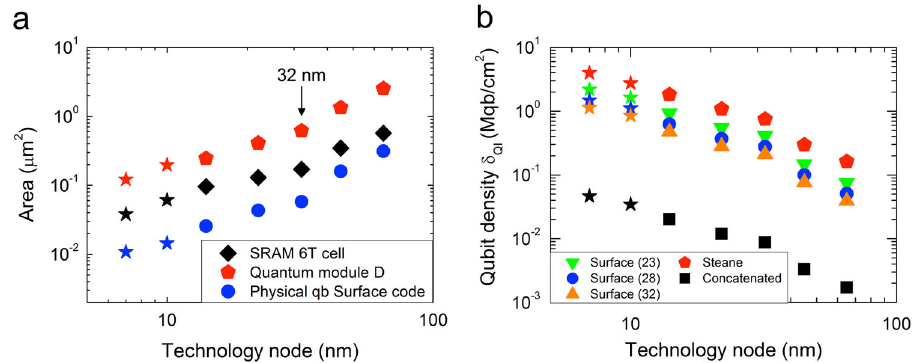
Fig. 4 The quantum information density scaling law. a Comparison between the trend line of the area occupied by a reference SRAM classical cell and a CMOS physical qubit for both Steane (module d ) and surface codes, respectively. The change in the trend at 32-nm node is due to different scaling law of the gate length below 32 nm. Stars refer to the forecasts of future nodes, namely, 10 and 7 nm, not yet available for industrial production. References for SRAM cells are the same reported in Table 2. b The quantum information density scaling law expressed as the maximum processable quantum information in terms of logical qubit number per surface unit as a function of the technology node. The concatenated code ( black ) is based on the Steane code [7,1,3] and lowers the quantum information density of two orders of magnitude with respect to the bare Steane code ( red ). The quantum information density is calculated for the surface codes at typical d values ( green for d = 23, blue for d = 28, and orange for d = 32). The stars correspond to forthcoming nodes, not yet realized and therefore subject to possible speci fi cation changes. The existing nodes and future ones ( stars ) are derived from IEDM and ITRS published speci fi cations following the analysis in Table